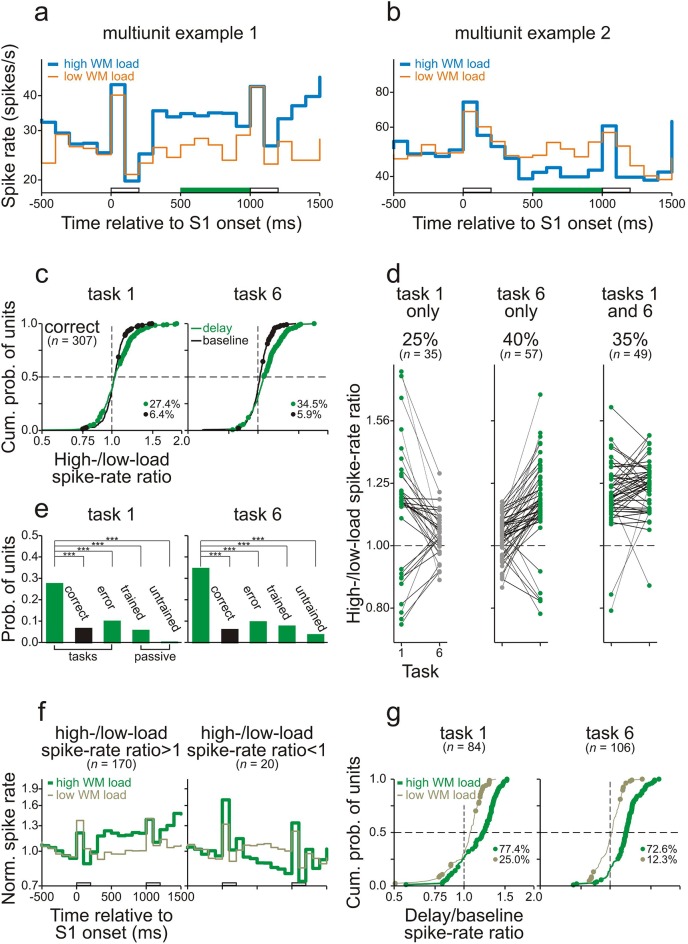
Working-memory related spike activity in monkey auditory cortex.(a, b) The spike rates of two representative multiunits recorded in AC while the monkeys performed task 6 correctly. Thick and thin traces represent spike rates in high- and low-WM-load trials, respectively. S1 was 1 kHz (blue) in high-WM-load trials and 3 kHz (orange) in low-WM-load trials. The green bars on the abscissae represent the final 500 ms of the delay during which the high-/low-load spike-rate ratios differed significantly from 1. In the example in panel a, the spike rate is higher, and in the example in panel b lower, in high- than in low-WM-load trials. The empty bars on the abscissae represent the timing and duration of S1 and S2. (c) The high-/low-load spike-rate ratios during the final 500 ms of the delay (green) and during the 500 ms directly before S1 (baseline; black) for all multiunits. Significant ratios are marked by dots. The proportions of units with significant ratios are also provided. Left and right panels show the ratios obtained when the monkeys performed task 1 and task 6 correctly. The horizontal dashed lines mark the median cumulative probability and the vertical dashed lines the ratio of 1. (d) Task and stimulus specificity of high-/low-load spike-rate ratios during the final 500 ms of the delay. Ratios obtained from a given unit in tasks 1 and 6 are connected by a line. Spike-rate ratios which are significantly different from 1 are represented by green dots, those which are not by gray dots. The left, middle, and right panels show the data from all units where the ratios were significantly different from 1 in task 1 only, in task 6 only, or in tasks 1 and 6, respectively. The 65% of units with significant ratios in one task only are considered to be involved in WM. The proportions and the numbers of units in the three groups are also provided. (e) Dependence of the occurrence of significant high-/low-load spike-rate ratios on the behavioral context. The green bars show the probability of units with significant ratios during the delay of correct trials, of error trials, and during passive conditions in the two trained monkeys and in the untrained monkey. The black bar shows the probability of units with significant ratios during the baseline of correct trials. The asterisks indicate significant differences between the conditions (chi-square test, one-tailed, p<0.001). (f) The mean spike rates in high- (thick traces) and low-WM-load trials (thin traces) for units with high-/low-load spike-rate ratios significantly >1 (left panel) or <1 (right panel). They were obtained by geometric averaging after normalizing each response to baseline. (g) Dominance of delay enhancement in AC. Distributions of the delay/baseline spike-rate ratios are shown separately for high- and low-WM-load trials and for task 1 and task 6. Ratios >1 represent delay enhancement and ratios <1 delay suppression. Significant ratios are marked by dots. Analyses were performed only on units with significant high-/low-load spike-rate ratios during the final 500 ms of the delay (panel c). The proportions of units with significant delay/baseline spike-rate ratios are also provided for high- and low-WM-load trials, respectively.DOI:
http://dx.doi.org/10.7554/eLife.15441.00810.7554/eLife.15441.009Figure 4—source data 1.Working-memory related neuronal activity identified by between-task comparison.The table shows numbers and percentages (in brackets) of recording sites where the neuronal activity during the final 500 ms of the delay was significantly different in high- and low-WM-load trials with the same S1s (p<0.05, permutation test). Numbers of sites with significant differences in spike activity in core fields of AC, in the LFP in core fields of AC, and in spike activity in vlPFC are presented in rows. Numbers of sites with a significant difference only when S1 was A (tone A only), only when S1 was B (tone B only), or when S1 was A and when it was B (tones A and B), are presented in separate columns. The total number of recording sites was 307 for spike activity in core fields of AC, 310 for the LFP in core fields of AC, and 238 for spike activity in vlPFC.